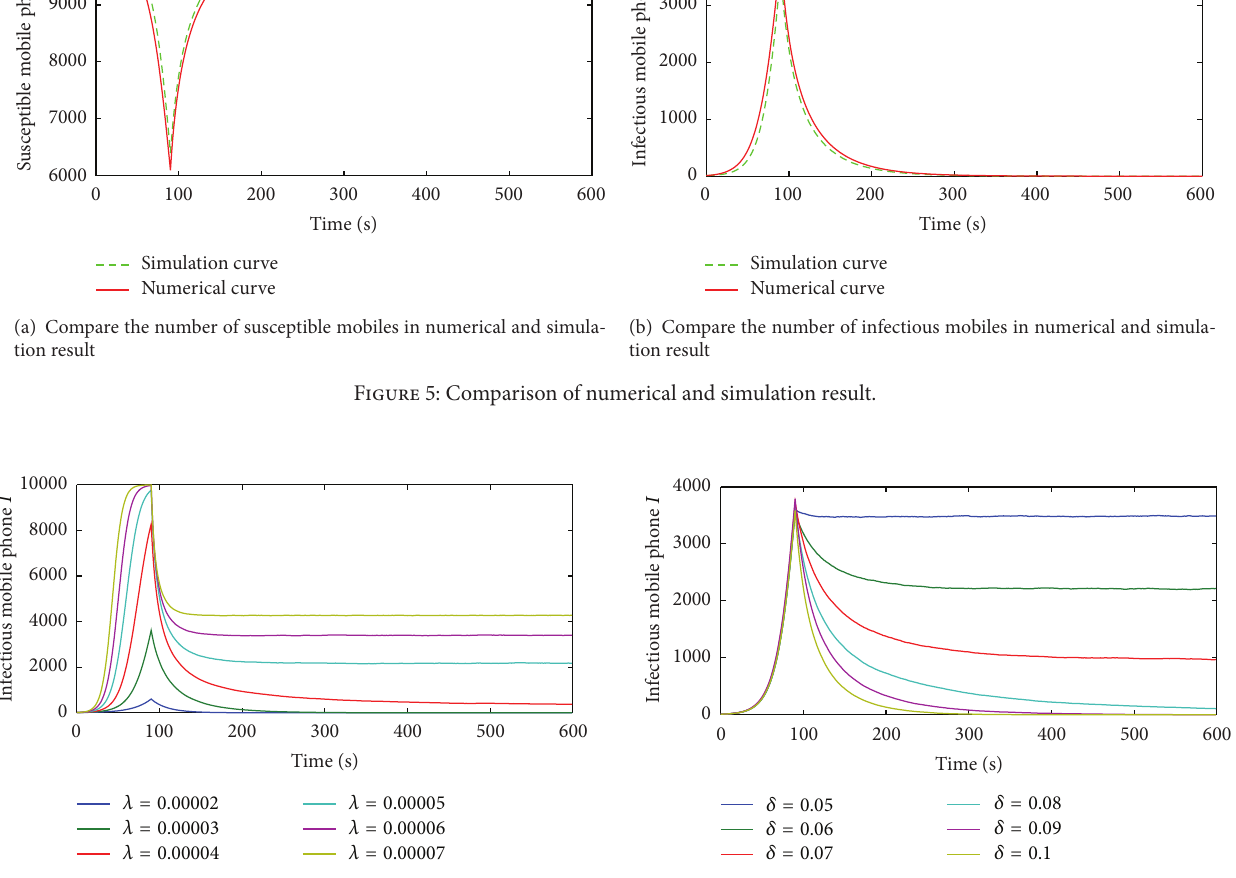
Figure 7: Impact of infection recovery rate 𝛿 on the M-SIS model.